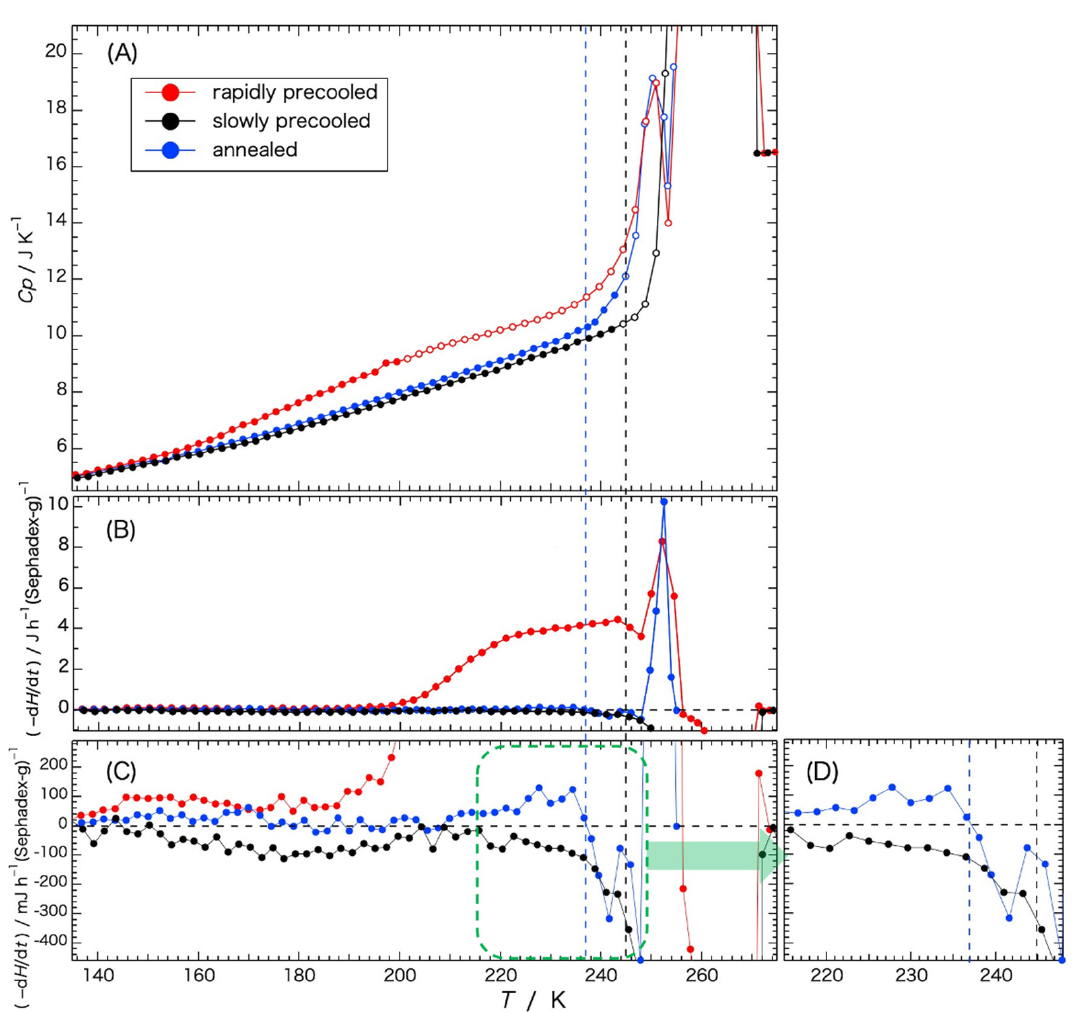
Figure 3. Rates of the enthalpy change –(d H /d t ) dependent on the rate of previous cooling –(d H /d t ) > 0: enthalpy release; –(d H /d t ) < 0: enthalpy absorption. ● : rapidly precooled, ● : slowly precooled, ● : annealed. Data of the heat capacity shown in Figure 2 are redisplayed in ( A ) for reference. A vertical enlargement of ( B ) is shown in ( C ). A lateral enlargement of the green dashed-line area in ( C ) is shown in ( D ). The vertical dashed line in blue represents the annealing temperature and the vertical dashed line in black the initiation temperature of ice melting.